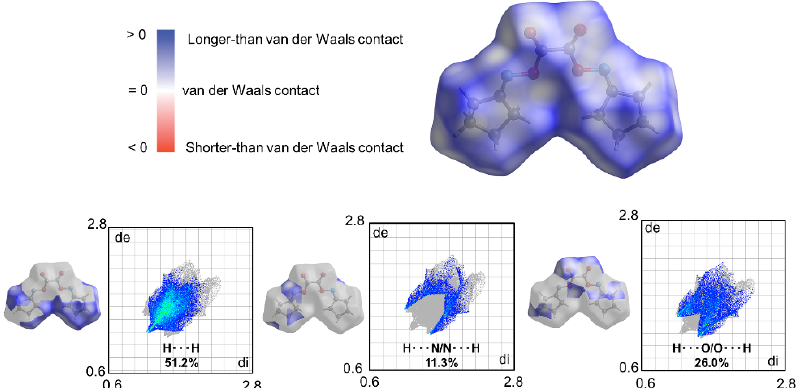
Figure 2. Hirshfeld surface mapped over d norm and 2D-fingerprint plots, including relative contributions (%) to the Hirshfeld surface area for the various close intermolecular contacts.